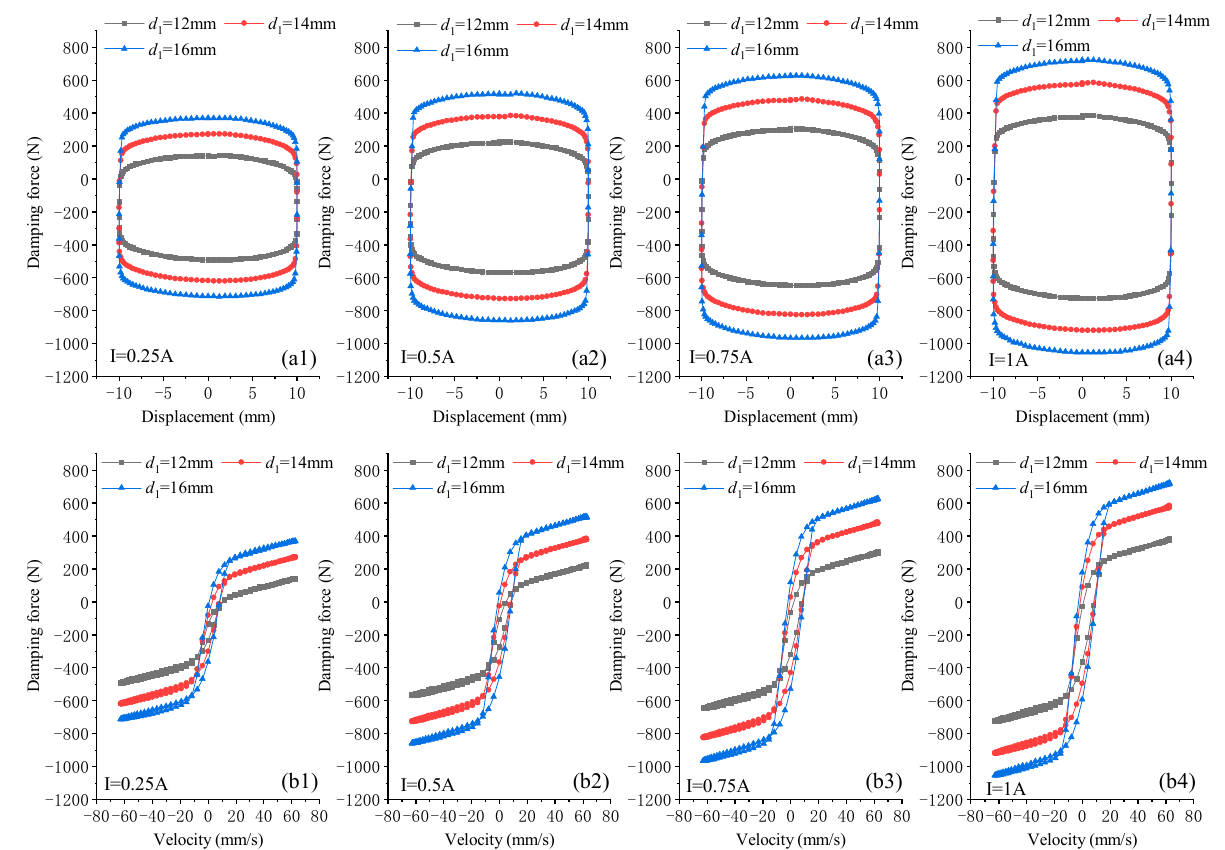
Figure 14. Damping characteristics of different magnetic yoke diameters for I = 0.25, 0.5, 0.75 and 1 A: ( a1 – a4 ) damping force–displacement; and ( b1 – b4 ) damping force–velocity.